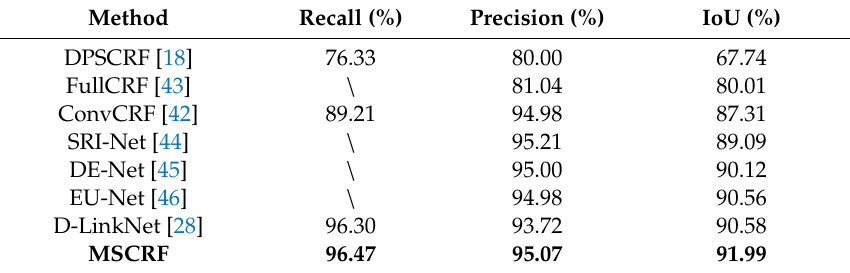
Table 1. Quantitative evaluation of building extraction from the WHU